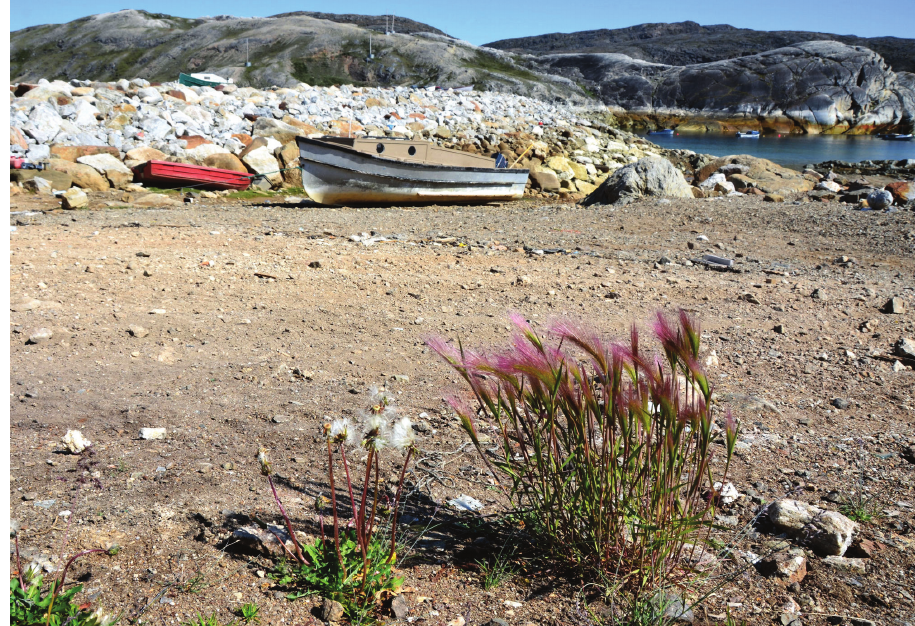
Figure 8. Hordeum jubatum subsp. jubatum : habitat, Saarela et al. 2737 . Photograph by R.D.